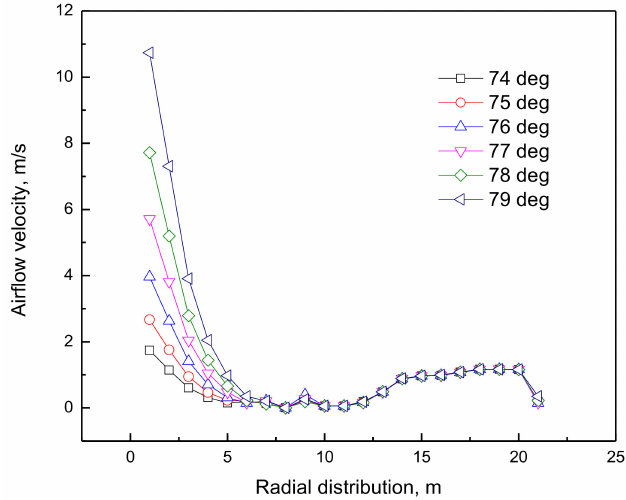
Figure 11. Radial distribution of edge airflow velocity under different bosh angles.